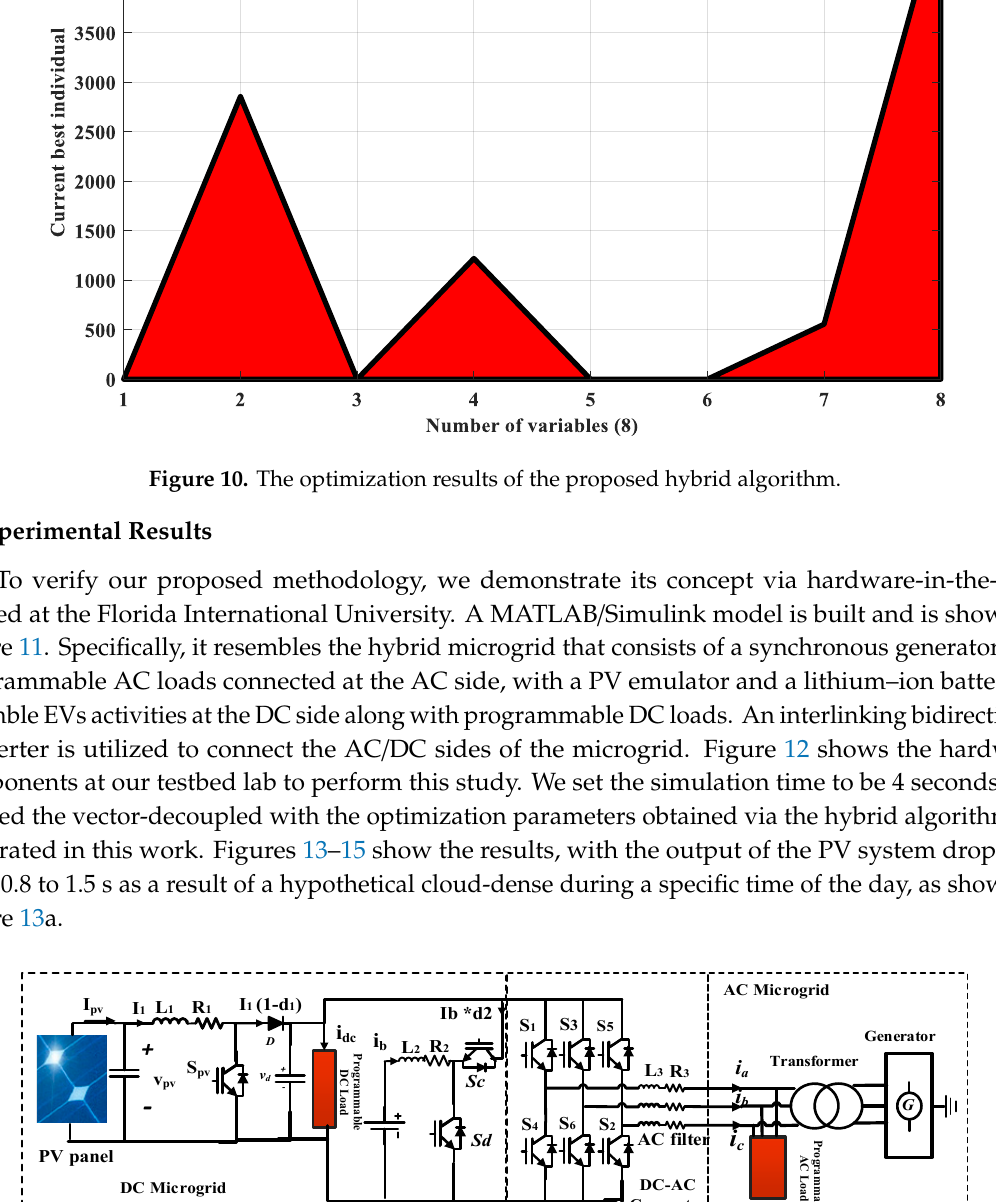
Figure 9. Convergence performance of the proposed algorithm.